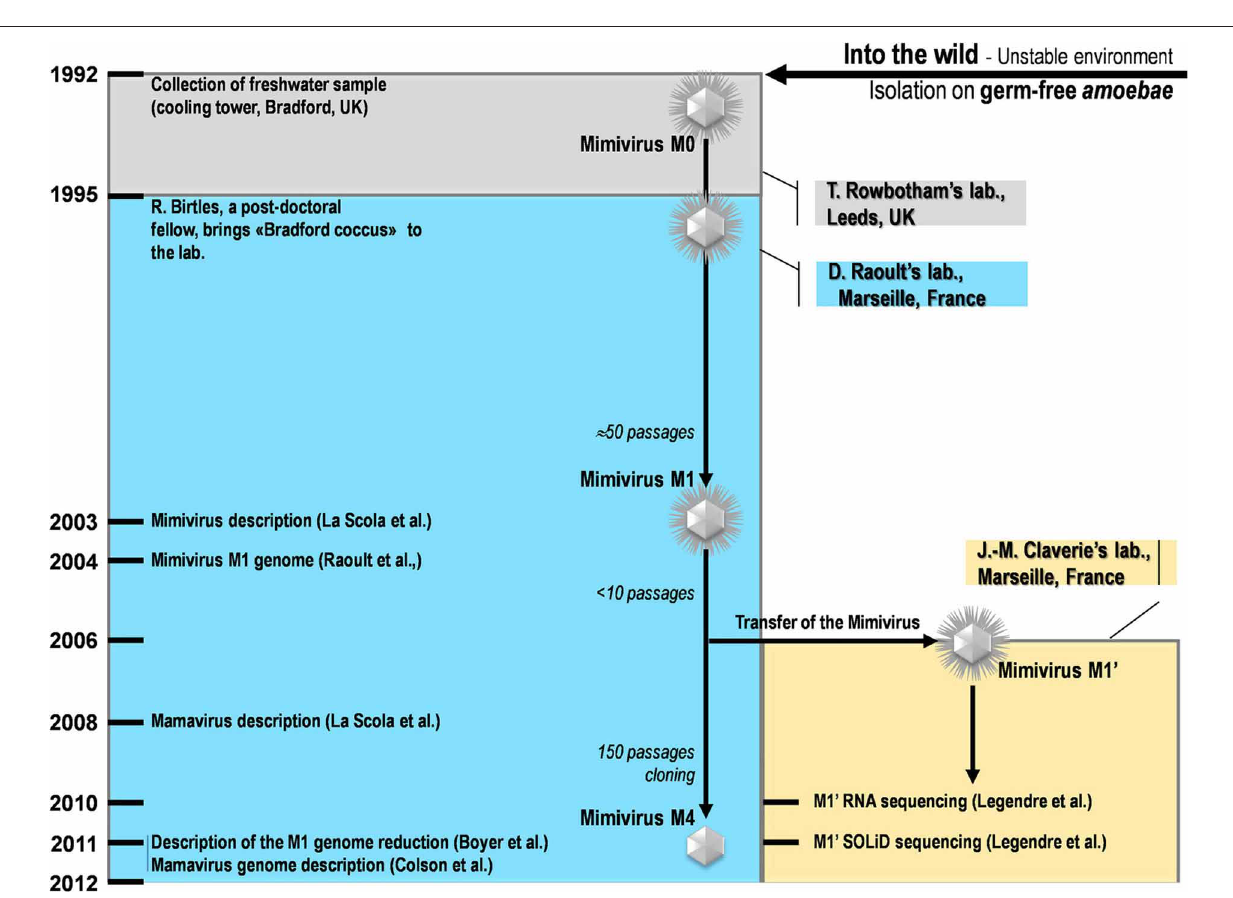
Frontiers in Cellular and Infection Microbiology